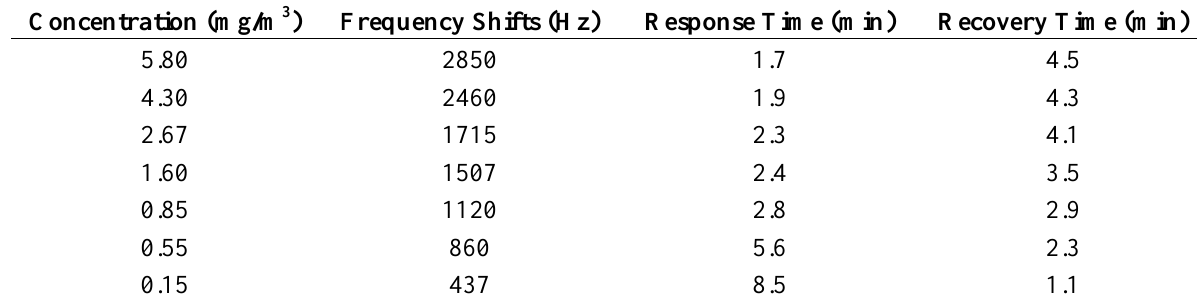
Table 1. Response of different concentrations to VX (20 °C, RH =